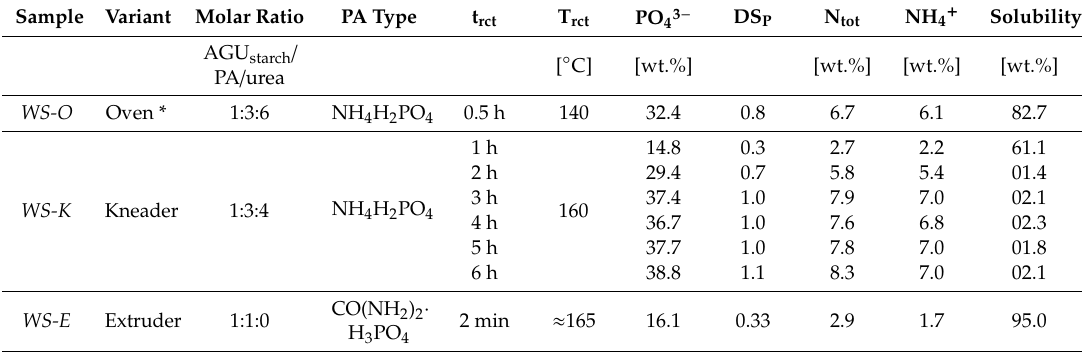
Table 1. Reaction conditions and results of wheat starch functionalization in PA / urea